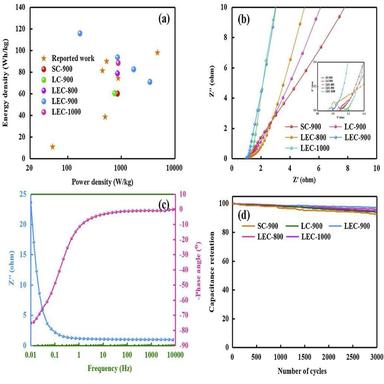
(a) Comparison of the energy and power density values for various samples with data reported in the literature; (b) electrochemical impedance spectra of different samples; (c) Bode plot of the phase angle and the electrochemical impedance of the LEC-900 sample; and (d) capacitance retention of various specimens over 3000 cycles.